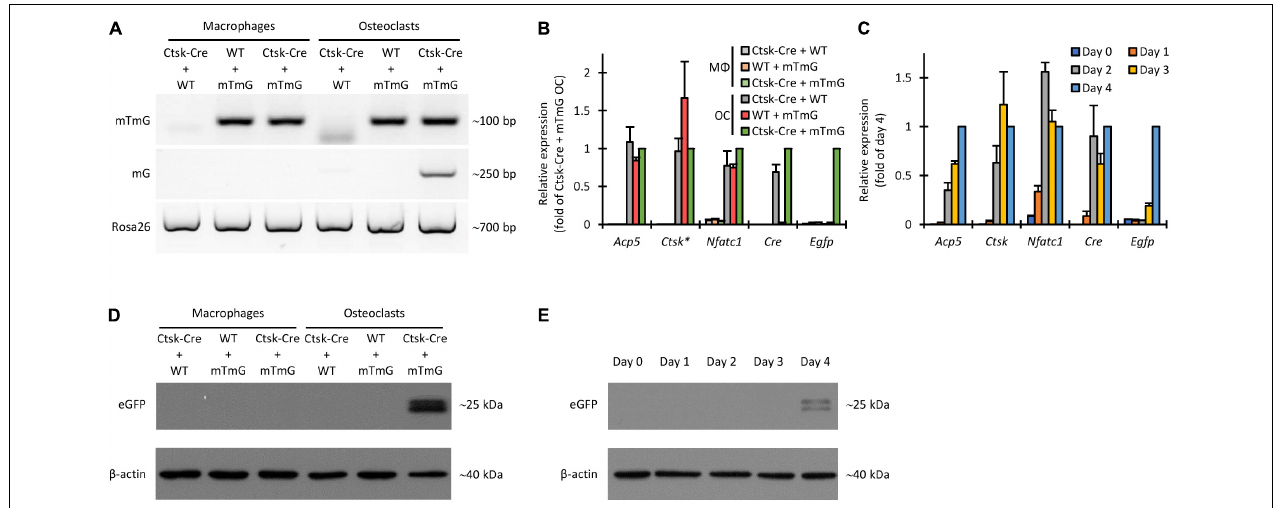
FIGURE 9 | Non-fluorescence-based assessment of Cre-mediated recombination in the FRAMCO1.2 assay. (A) Genomic PCR analysis of Cre-mediated recombination with primers amplifying a loxP-flanked portion of the mTmG construct (upper row), an ∼ 250 bp region from the recombined (mG) allele (middle row) or a downstream region of the Rosa26 locus unaffected by the mTmG mutation (lower row). (B) RT-qPCR analysis of different transcripts on Day 4 in macrophage (M (cid:56) ) or osteoclast (OC) cultures. The asterisk indicates that Ctsk expression values for samples with half of the cell-population carrying the Ctsk-Cre mutation were multiplied by 4/3 to compensate for the haploinsufficiency of the wild-type Ctsk allele. All samples were normalized to Ctsk-Cre + mTmG osteoclast values. (C) RT-qPCR analysis of the time course of expression of the indicated genes during differentiation of Ctsk-Cre + mTmG osteoclast co-cultures relative to Gapdh . Data were normalized to Day 4 expression values of the respective transcripts. (D,E) Immunoblot experiments detecting eGFP and β -actin as loading control from whole cell lysates of the indicated co-cultures on Day 4 (D) or from Ctsk-Cre + mTmG osteoclast co-cultures on the indicated days (E) . Panels (A,D,E) are representative of 3–6 independent experiments. Panels (B,C) show mean and SEM from 4 to 7 independent experiments.